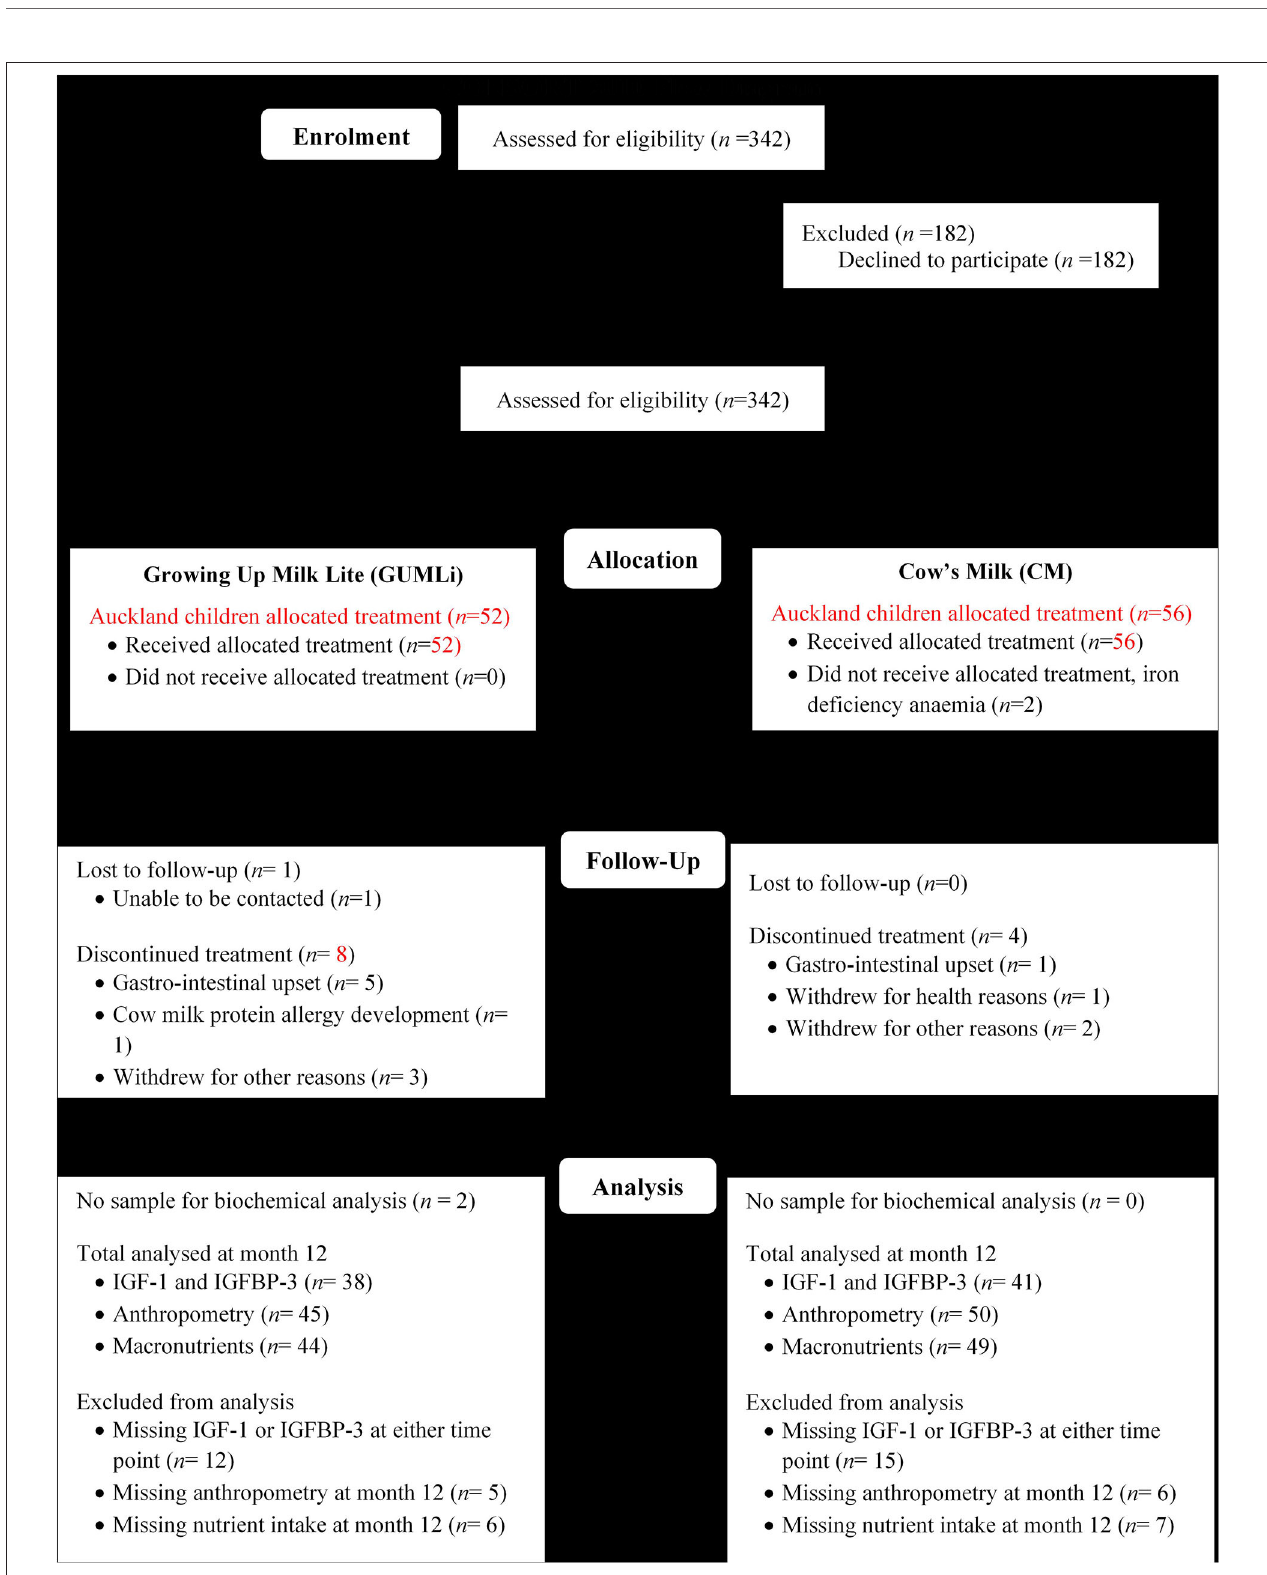
FIGURE 1 | Modified CONSORT flow diagram showing Auckland GUMLi Trial participant randomisation, allocation, follow up and study analysis. CONSORT, CONsolidated Standards Of Reporting Trials; IGF-1, insulin-like growth factor 1; IGFBP-3, insulin-like growth factor binding protein 3.